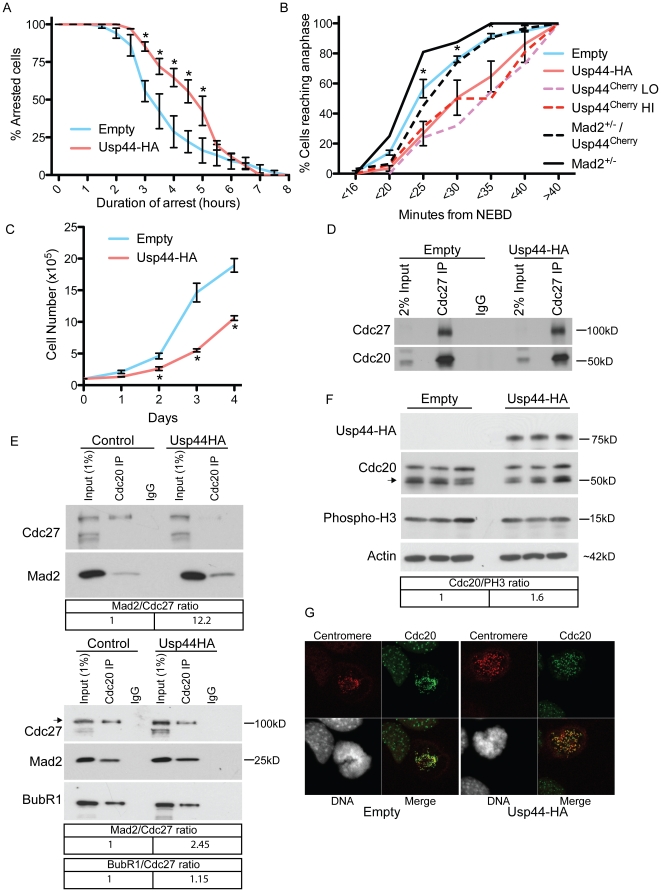
Usp44 expression leads to reduced mitotic slippage.(a) The duration of mitotic arrest in nocodazole was determined for MEFs transduced with either empty vector or Usp44-HA (n = 40–60 cells each). Chromosomes were visualized by prior transduction with lentivirus expressing H2B-YFP. After the addition of nocodazole, cells entering mitosis (for up to 20 minutes) were marked and followed by time lapse imaging for over 9 hours. The duration of arrest was defined as the time from nuclear envelope breakdown (NEBD) to de-condensation of chromosomes and nuclear reformation. (b) The duration of mitosis was determined by live-cell microscopy of MEFs with the indicated constructs. All cells were transduced with H2B-YFP and the time from nuclear envelope breakdown (NEBD) to anaphase onset was determined. N = 79 cells with control, 84 with Usp44-HA, 21 Usp44CherryLO, 20 Usp44CherryHI. p-values were calculated using the 2-way ANOVA. (c) The growth of cells was determined for three independent MEF lines transduced with either empty vector, or Usp44-HA. Viable cells were counted daily in triplicate using trypan blue exclusion. (d) Immunoprecipitation of Cdc27 from MEFs with or without over-expressed Usp44-HA. Precipitated material was immunoblotted with the indicated antibodies. (e) Immunoprecipitation of Cdc20 from MEFs with or without over-expressed Usp44-HA. Two results out of six independent experiments are shown. Relative amounts of Mad2 and BubR1, normalized to the mount of Cdc27 retrieved, are shown. (f) Three independent MEF lines were transduced with the indicated constructs and mitotic cells isolated by shake-off in the presence of nocodazole. Extracts were probed with the indicated antibodies. (g) Cdc20 localization was assessed by confocal microscopy on MEF cultures transduced with the indicated constructs. Images are representative of the results seen in three independent MEF lines. Relative amounts of Cdc20, normalized to the amount of PH3, are shown. * Unless otherwise noted, p<0.05 for each indicated time point calculated with an unpaired t-test. Error bars represent the SEM.